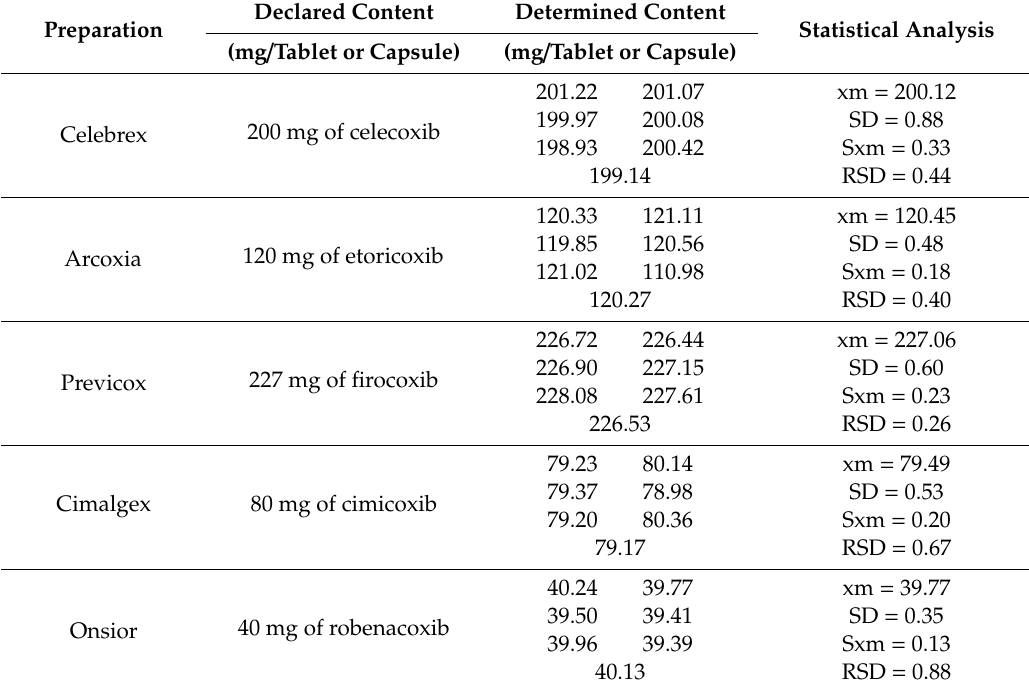
Table 5. Results from assay of celecoxib, etoricoxib, firocoxib, cimicoxib and robenacoxib in their pharmaceutical